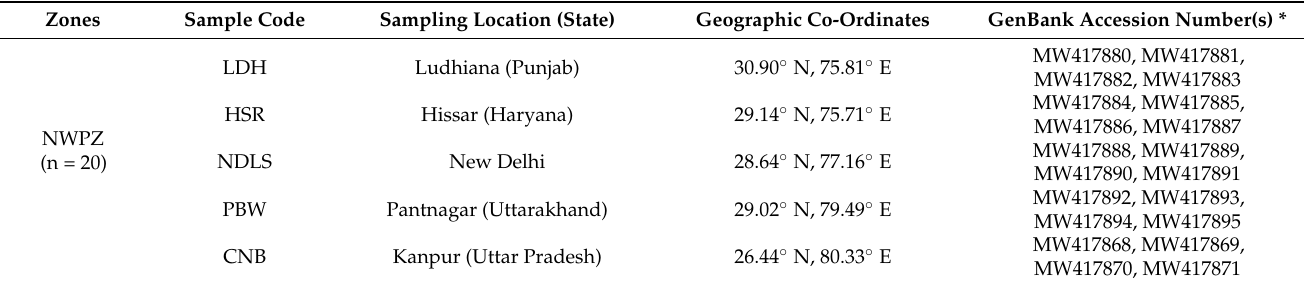
Figure 1. Sampling locations for collection of field populations of M. vitrata across India. Table 1. Sampling details of M. vitrata populations from ecologically diverse pigeonpea growing zones of